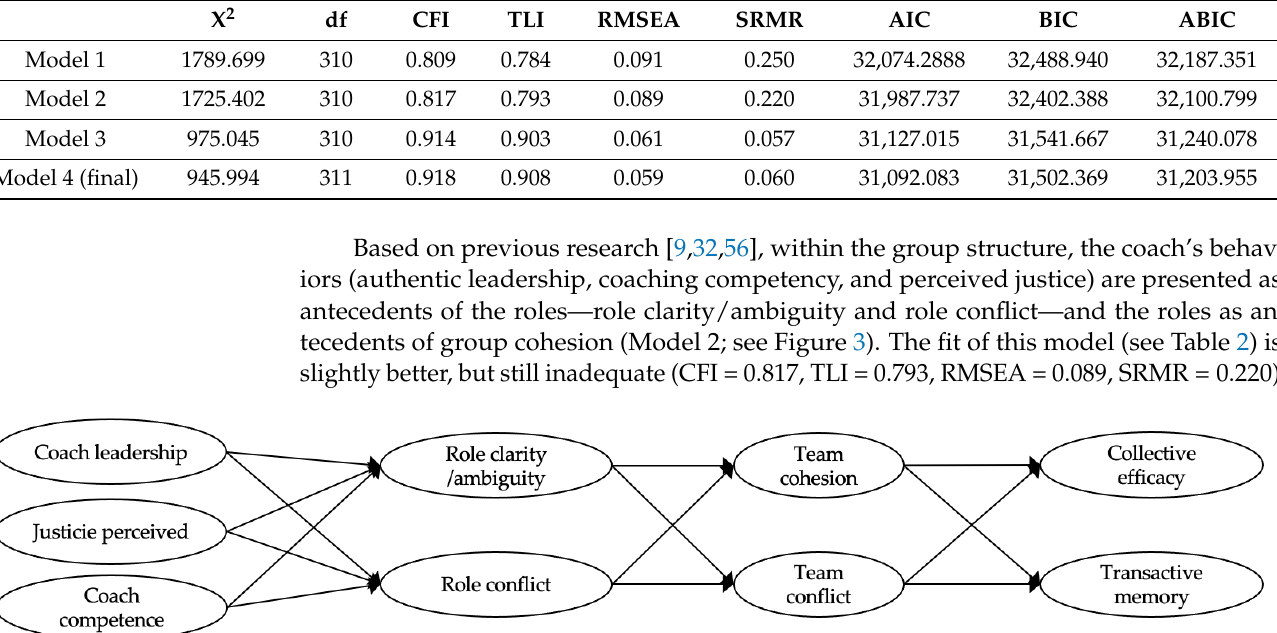
Figure 2. The hypothesized Model 1 of the relationships among variables. Table 2. Fit Indices of the different models.